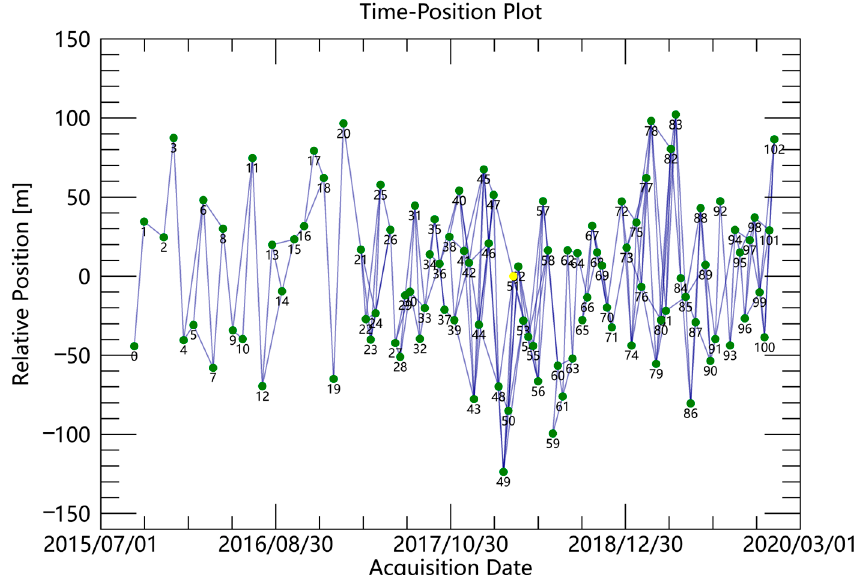
Figure 4. Spatial and temporal baselines of the interferometric pairs (the x axis represents the temporal baseline, the y axis represents the perpendicular baseline, and the yellow solid point represents the selected master image in our data).